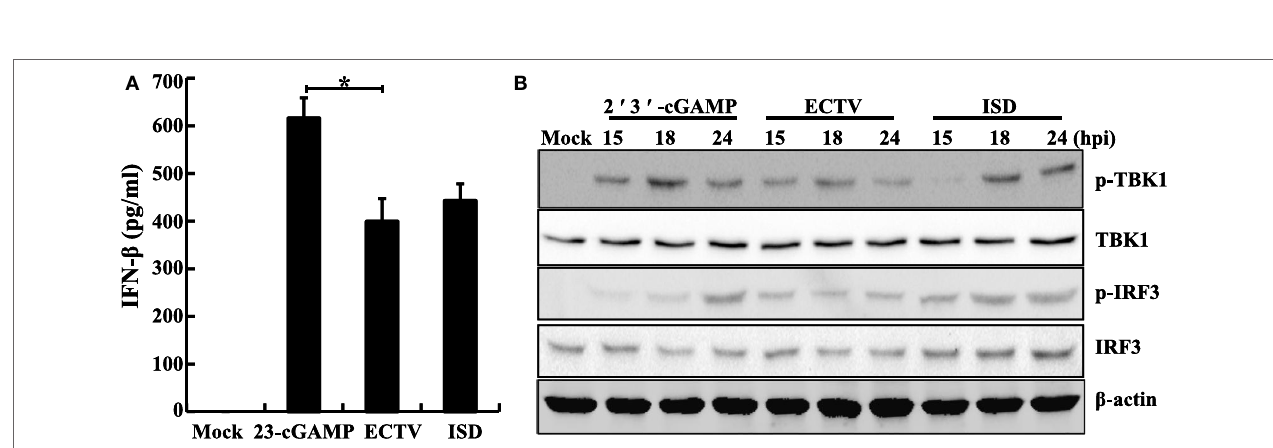
FigUre 2 | Sting and cGas are required for the induction of IFN- β during ectromelia virus (ECTV) infection in L929 cells. (a) Western blot analysis of overexpressed cGas, Sting, and β -actin protein levels in L929 cells. (B) L929 (2 × 10 5 ) cells were seeded in a 12-well plate and then were transfected with cGas, Sting-wt (S-wt), Sting-gt (S-gt), or empty (Vec.) plasmids. Thirty hours after transfection, cells were infected with ECTV (MOI of 5) for 18 h, and then the mRNA levels of IFN- α , IFN- β , and Ifit1 were analyzed by qPCR. (c) Western blot analysis of siRNA knockdown of cGas, Sting, and β -actin protein levels in L929 cells. (D) L929 (2 × 10 5 ) cells were seeded in a 12-well plate and then were transfected with siRNAs for cGas (si-C1 and si-C2), Sting (si-S), or si-NC (si-N). Thirty-six hours after transfection, cells were infected with ECTV (MOI of 5) for 18 h, and then the mRNA levels of IFN- α , IFN- β , and Ifit1 were analyzed by qPCR. All the data represent mean ± SD of biological triplicates from at least three independent experiments. Statistical analyses were performed by one-way analysis of variance followed by the Duncan’s multiple range test. Con. means control group, which cells were only infected with ECTV (MOI of 5). In this figure, * P ≤ 0.05 and ** P ≤